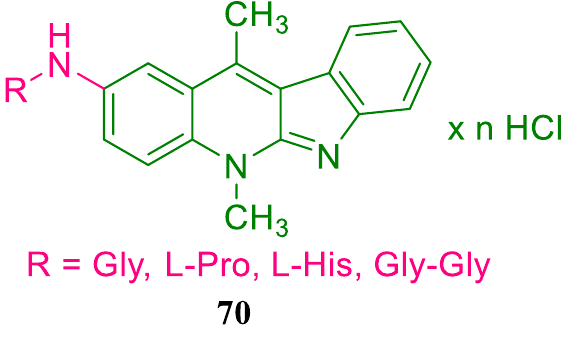
Figure 58. Neocryptolepine-amino acids analogues.